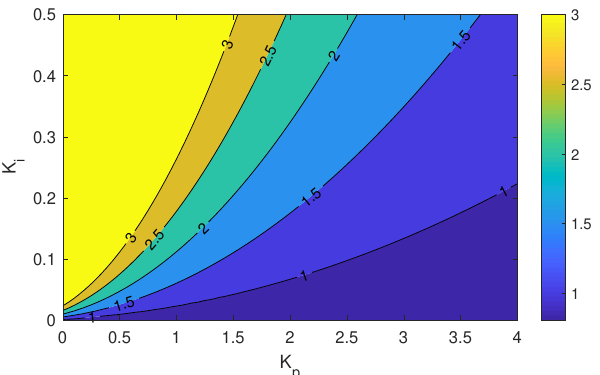
Figure 8. Level sets of (cid:107) W (cid:101) S (cid:107) ∞ for different values of K p and K i for the system with multiplicative feedback uncertainty.